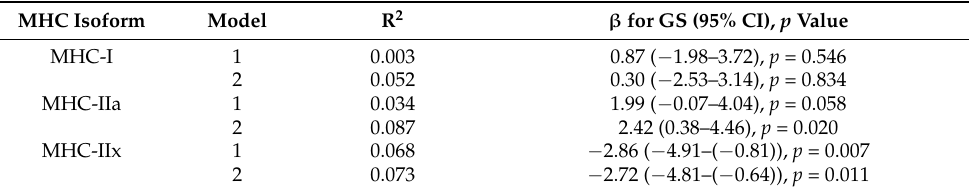
Figure 1. Correlations of the GS based on the TMPRSS6 rs855791 T/C and HFE rs1799945 C/G polymorphisms for iron status with the proportions of MHC-I ( a ), MHC-IIa ( b ), and MHC-IIx ( c ) isoforms for all; proportions of MHC-I ( d ), MHC-IIa ( e ), and MHC-IIx ( f ) isoforms in men; and proportions of MHC-I ( g ), MHC-IIa ( h ), and MHC-IIx ( i ) isoforms in women. GS: Genotype score; MHC: Myosin heavy chain. Table 2. Associations of the GS for iron status with the proportions of MHC-I, MHC-IIa, and MHC-IIx isoforms in